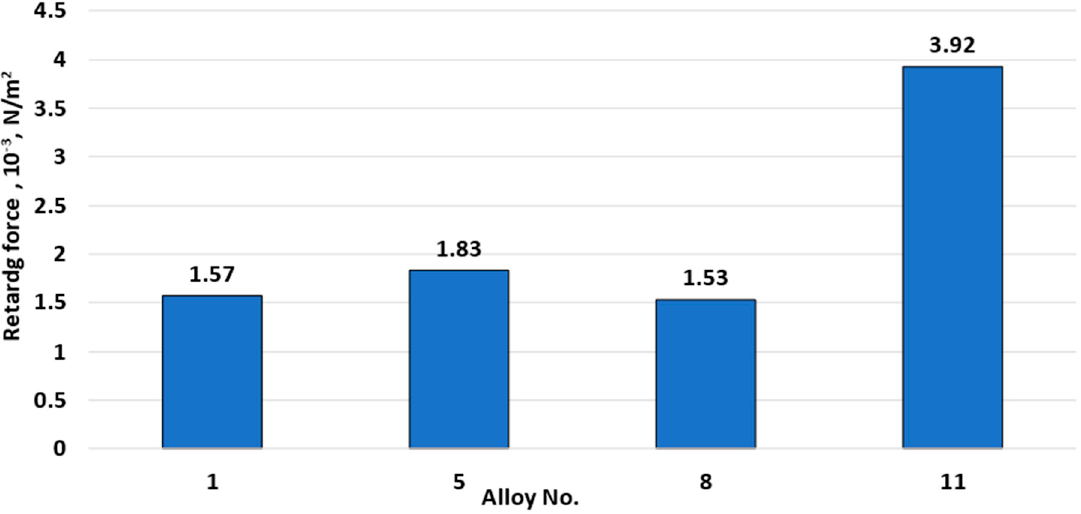
Figure 15. Changes in the recrystallization retarding force depending on alloy chemical composi- tion.